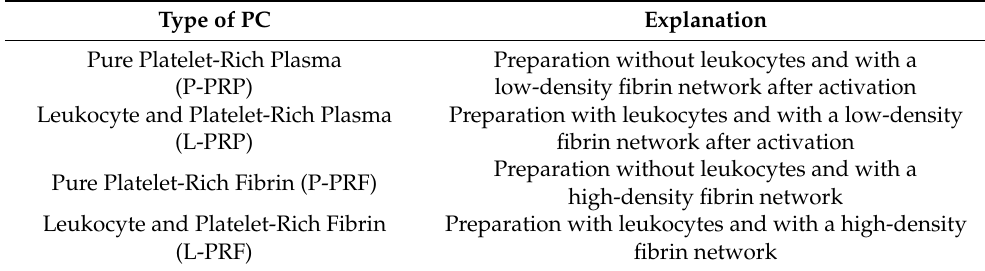
Table 1. Types of platelet-rich fibrin [12,13]. Type of PC Explanation Pure Platelet-Rich